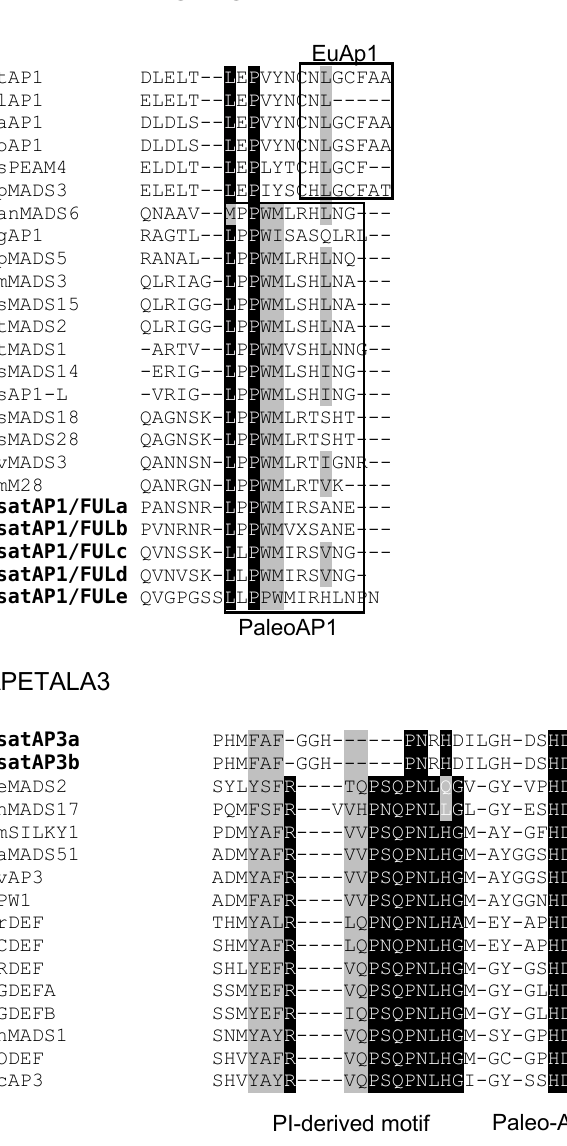
FIGURE 2 Alignment of the deduced amino acid (aa) sequences of the C-terminus of crocus MADS-box genes and other homologous plant MADS proteins constructed with Clustal W [42]. Identical amino acids are highlighted in black and similar amino acids in gray with a threshold for shading of 70% sequence similarity. For each lineage of the MADS-box proteins, characteristic motifs are boxed. Motifs are described in Vandenbussche et al.[43] and Kramer et al.[44]. Crocus sequences are indicated in bold (see text for